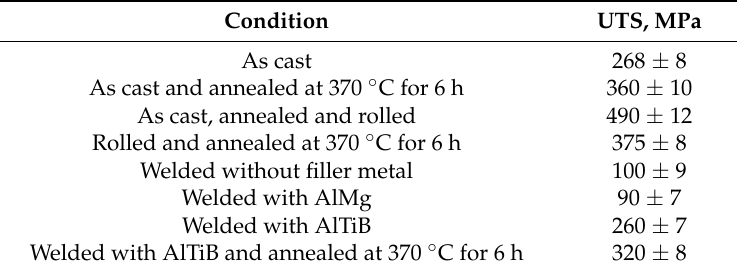
Table 2. UTS of the investigated alloy under the different conditions.